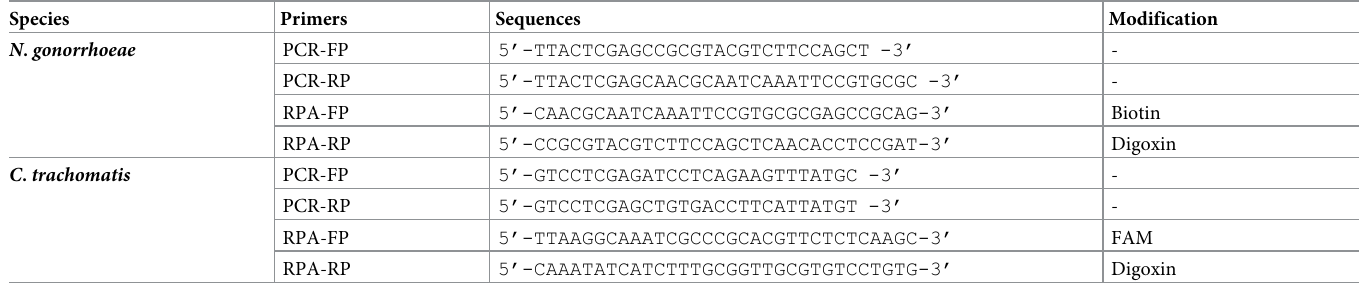
Table 1. Names and sequences of primers used in this